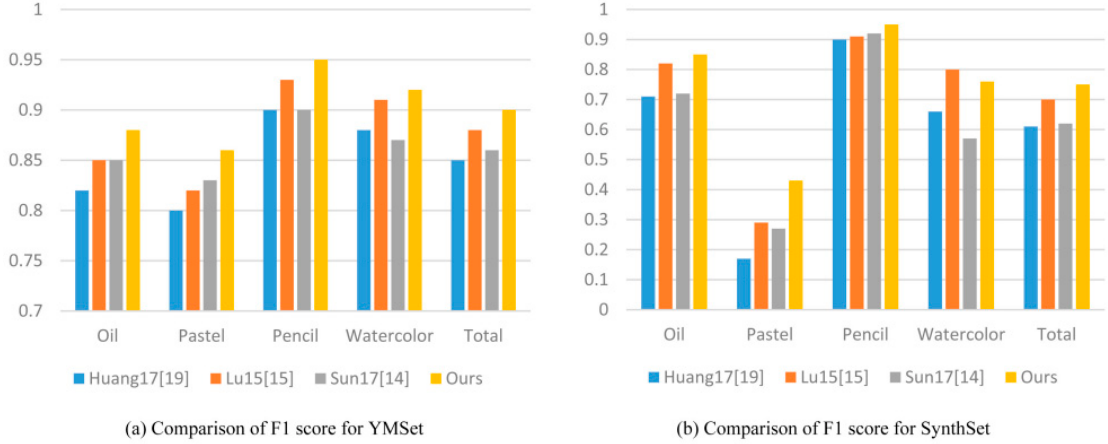
Figure 9. Comparison of F1 scores from the four recognizer models on YMSet ( a ) and SynthSet ( b ).